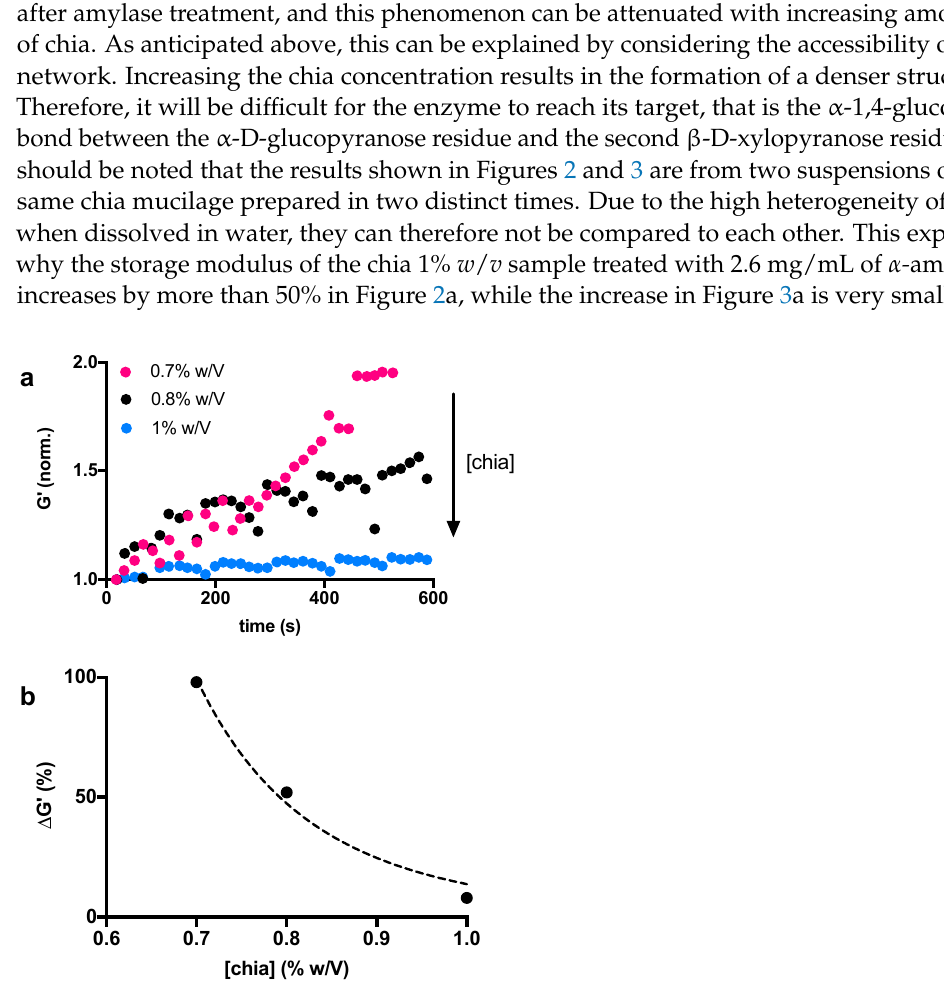
Figure 3. Chia mucilage storage modulus G’ changes over time at varying chia concentrations (0.7%, 0.8% and 1% w / v ) ( a ), and increment of elastic response over time (600 s) as a function of chia concentration ( b